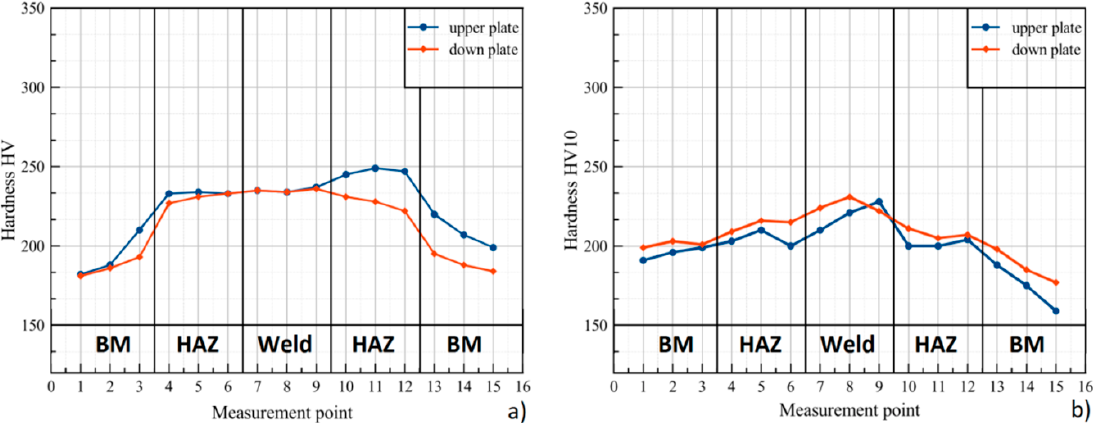
Figure 11. Results of hardness distribution in cross-section from ( a ) simulation and ( b ) experimental welding.